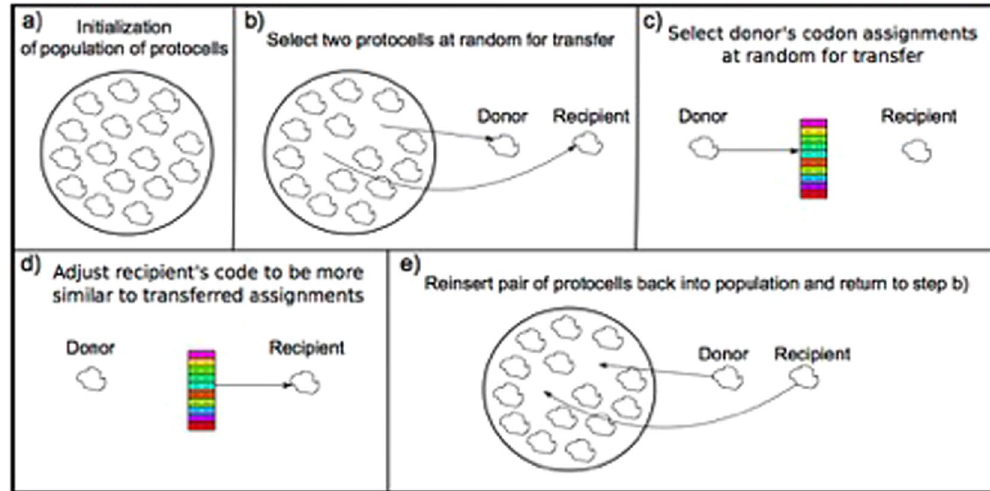
Figure 3. A model of communal evolution of the genetic code. ( a ) A small group of protocells is initialized such that their ‘black box’ primitive translation systems encode random genetic codes consisting of few amino acids. Then the ‘iterative learning’ cycle begins. ( b ) Two protocells are randomly selected for horizontal transfer of a fragment of the donor’s genetic code to the recipient. ( c ) A small subset of codon assignments is randomly chosen and transferred; occasionally, codon assignment inaccuracies can occur in the transferred components. ( d ) The recipient adjusts its genetic code to be more like the donor’s code according to the received assignments. ( e ) The process of horizontal transfer is completed. Then the cycle starts again by going back to ( b